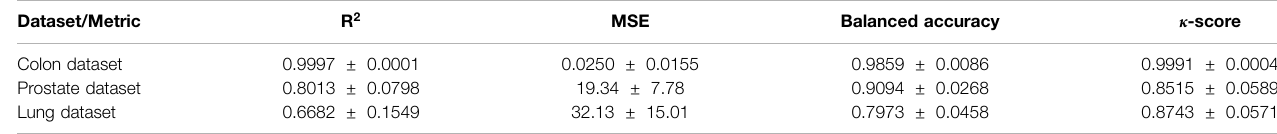
TABLE 3| Performance ofthescaledetector,evaluatedonthreedifferenttissuedataset. Thescaledetector isevaluatedin:coef fi cientofdetermination ( R 2 ) ,Meansquared error (MSE), balanced accuracy, Cohen ’ s κ -score. Dataset/Metric